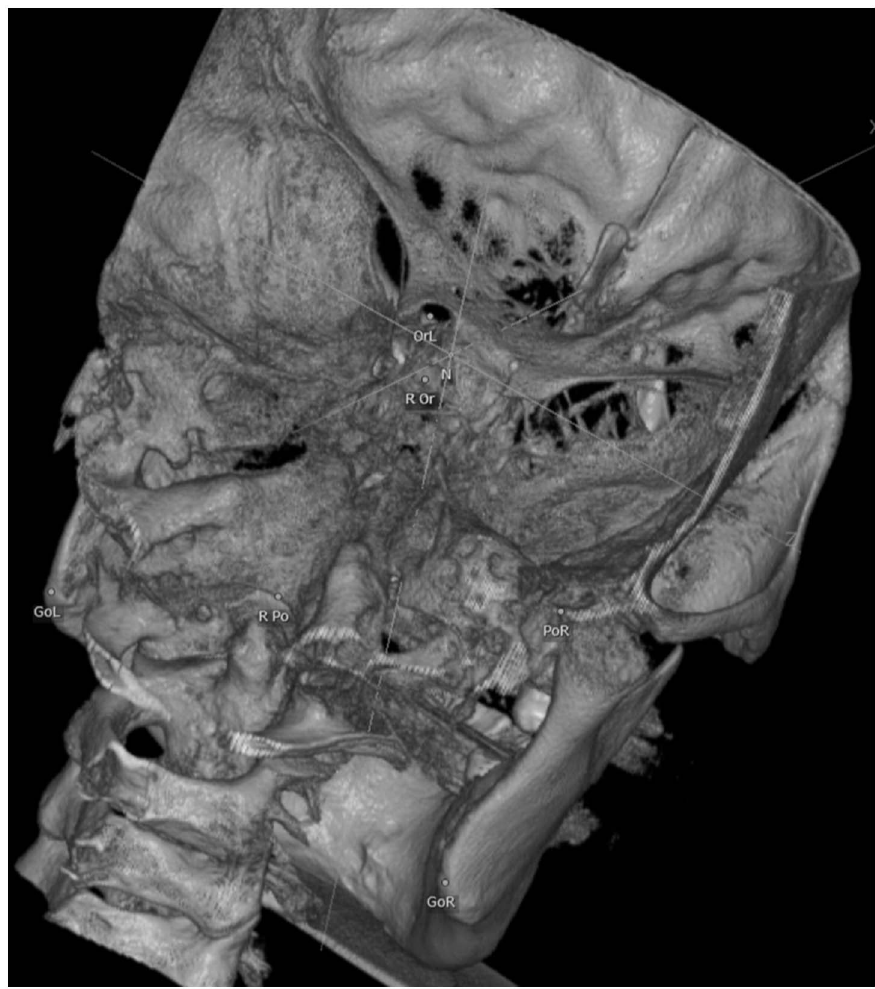
Figure 2. Landmarks after reorientation. N, ROr and RPo each refers to MLWS, S and Ba according to the initial setting of Ondemand 3Dceph module.